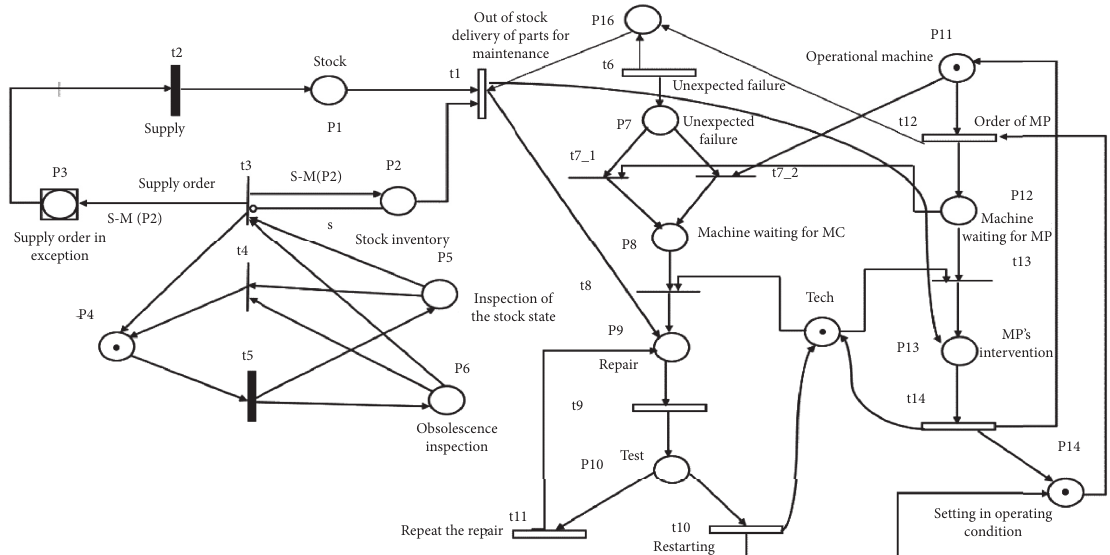
Figure 1: Spare parts and maintenance management model. Table 2: Designation of model